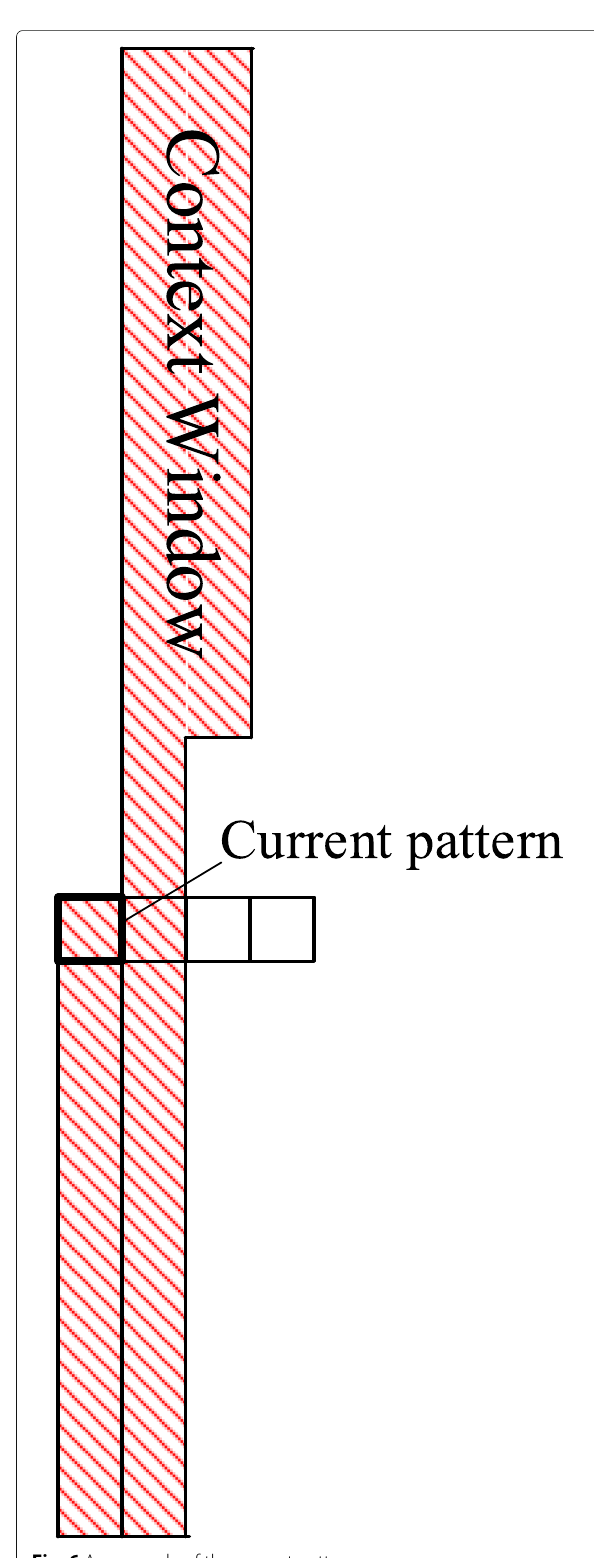
Fig. 6 An example of the current pattern